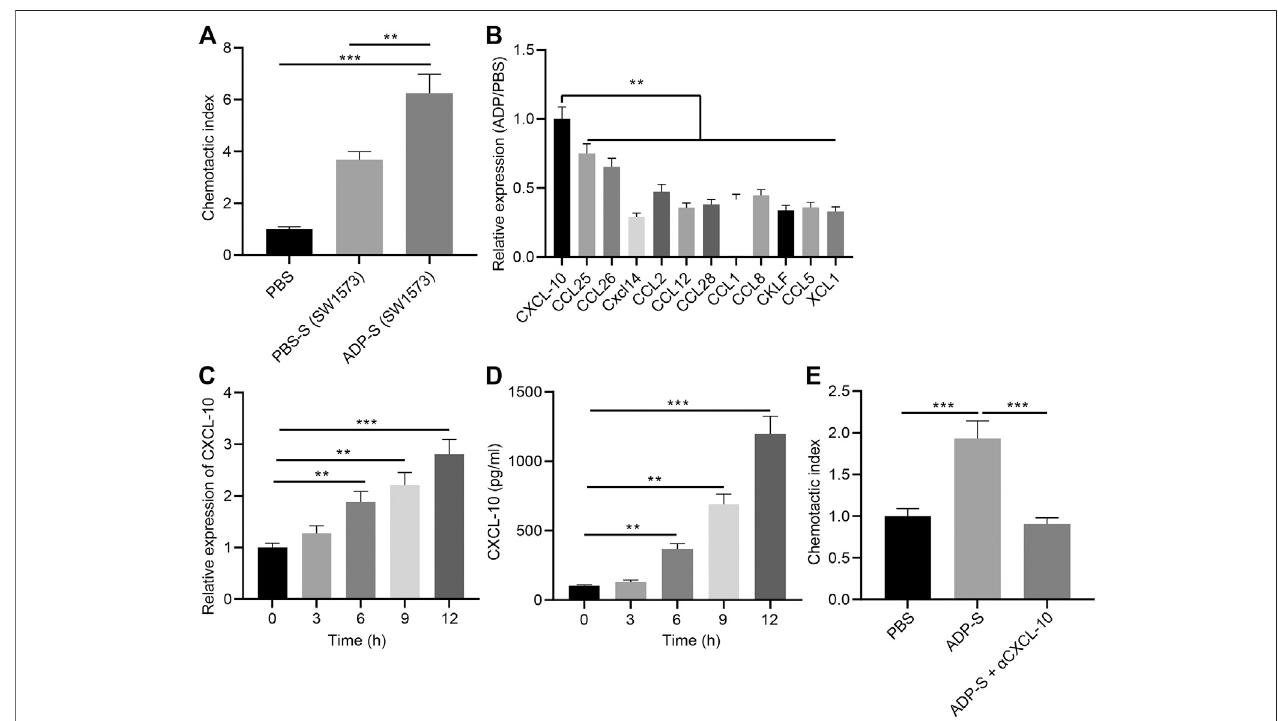
FIGURE 6 | ADP promotes CXCL10 secretion by stimulating alveolar epithelial cells. (A) The migration index of HMC-1 incubated with ADP-stimulated cell culture supernatantassessed byTranswellassay. (B) Theexpression ofvarious chemokines determined byRT-qPCR. (C) Quantitative analysisoftheexpression ofCXCL10 in ADP-stimulated alveolar epithelial cells at different time points. (D) The level of CXCL10 in ADP-stimulated alveolar epithelial cells detected by ELISA at different time points. (E) The migration ability of MCs incubated with ADP-stimulated cell culture supernatant. * p < 0.05, ** p < 0.01, and *** p < 0.001. Measurement data were expressed by the mean ± standard deviation, analyzed by independent sample t test, and the experiment was repeated three